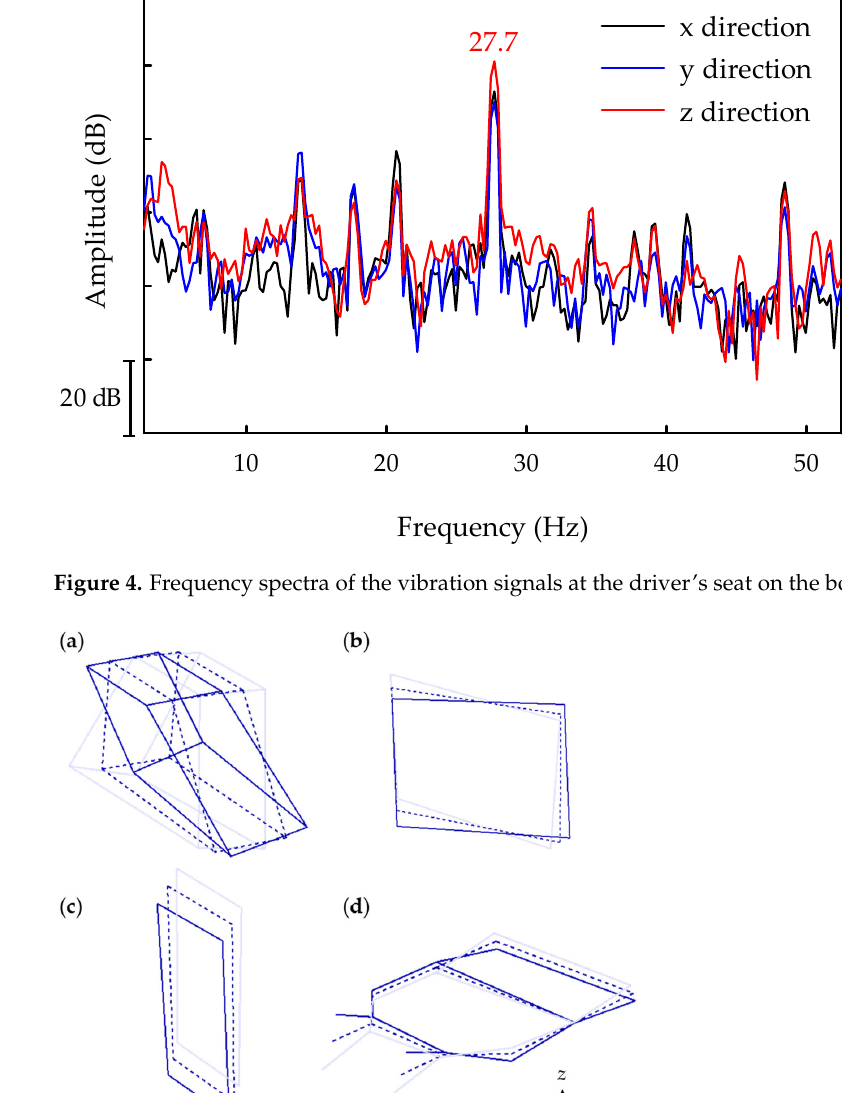
Figure 6. Impact and measurement points for the experimental modal tests: ( a ) powertrain; ( b ) ra ‐ diator; ( c ) intercooler; and ( d ) body floor.